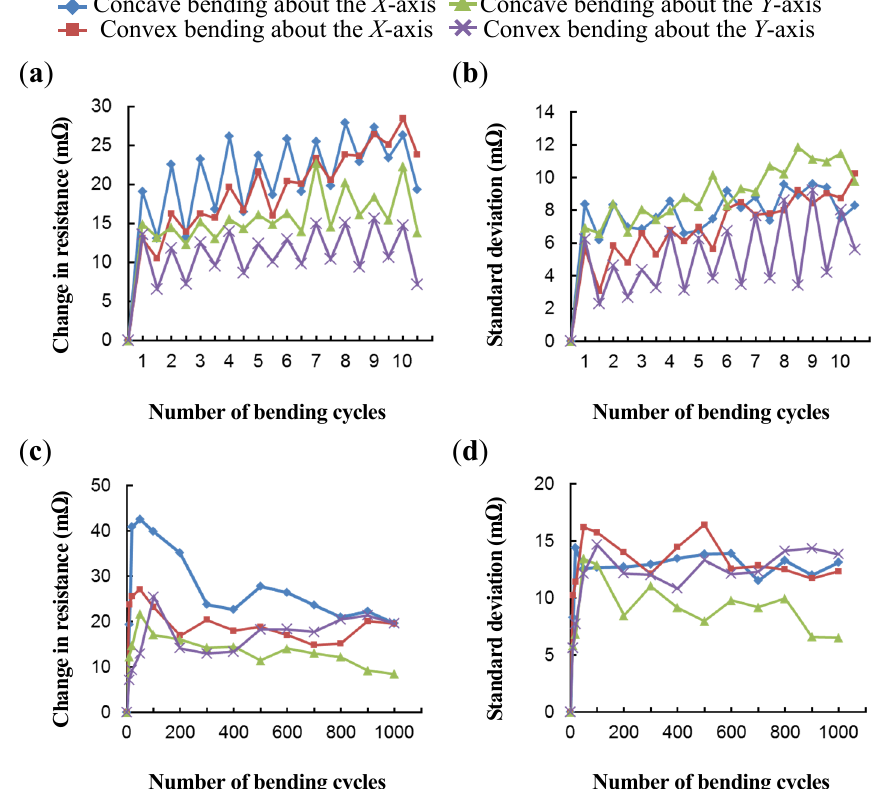
Figure 13. Change in resistance during the bending test for a curvature radius of 25 mm: ( a , b ) continuous measurements and ( c , d ) intermittent